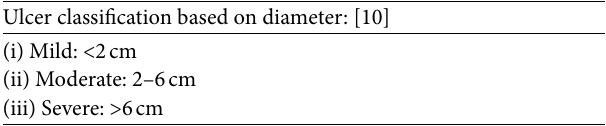
Table 1: Ulcer classification based on diameter. Ulcer classification based on diameter: